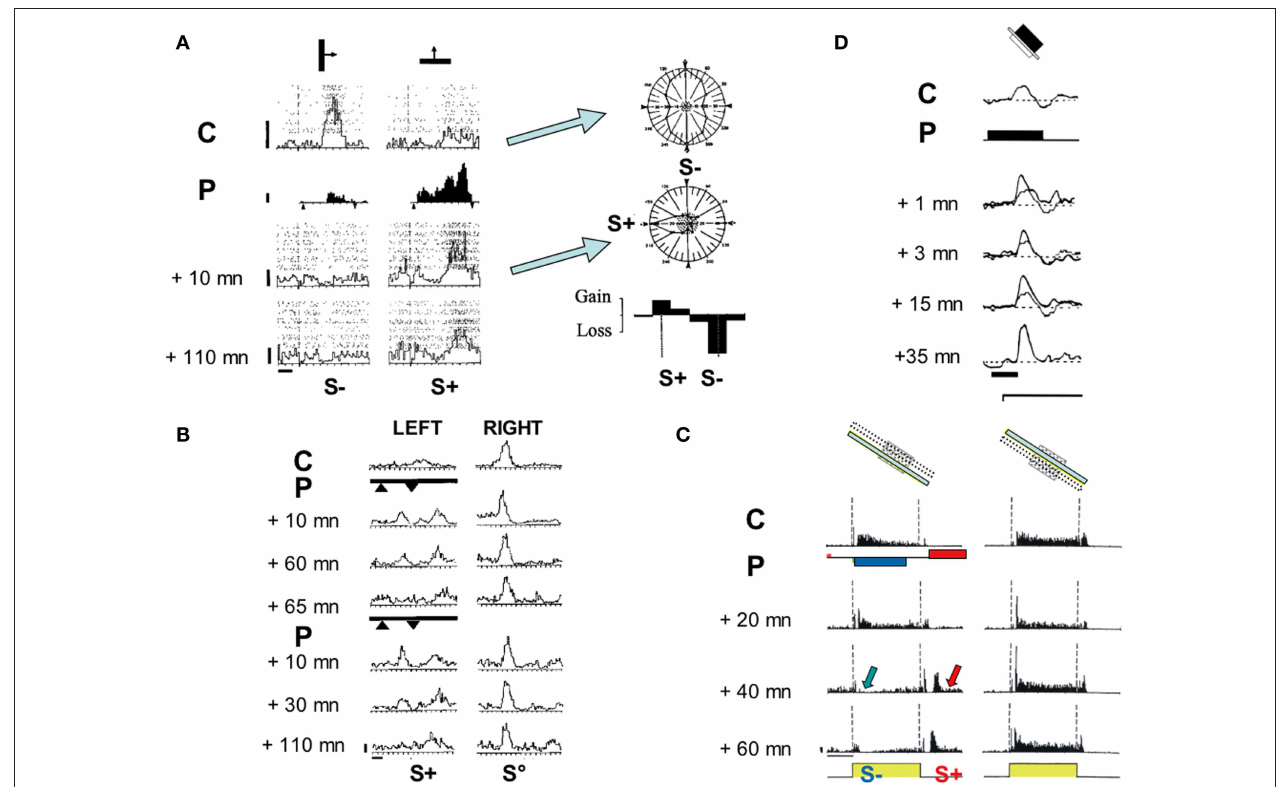
was retained for 60 min. After extinction ( + 65 min), this effect was reinstated by a second pairing (imposing a 90% increase in firing during 24 S + trials), which was retained for 110 min. The response to stimulation through the unpaired (S ° ) right eye was unchanged. Calibration: vertical 10 ap s − 1 , horizontal 1 s and 1.5 ° . (C) Change of the ON/OFF balance (adapted from Debanne et al., 1998). Cell recorded in a 6-week-old kitten. PSTHs represent the cell’s response to the presentation (ON) and extinction (OFF) of an optimally oriented bar in a fixed position of the RF (cartoon). Before pairing (C, control), a tonic “ON” response and a more transient “OFF” response were observed uniformly across the RF. The pairing procedure (P, data not shown) consisted of 50 associations of a negative current pulse ( − 3 nA, 2120 ms duration) with the onset of the light bar and a positive current pulse of similar duration ( + 3.2 nA) following the offset of the same stimulus with a constant delay of 500 ms. A progressive change developed over 40 min after pairing, resulting in a significant depression of the “ON” response ( p < 0.0005), whereas a late “OFF” response appeared de novo in the paired position. The latency of the new response precisely matched the onset delay of the iontophoretic pulse used during pairing. The “ON—OFF” ratio was unchanged in the unpaired position. The modification in the paired position was still present 1 h after the end of the pairing procedure, at which time the neuron was lost. Calibration bars: 1 s; 20 ap s − 1 . (D) Intracellular pairing (adapted from Frégnac et al., 1994b). Simple cell recorded intracellularly in vivo in a 10-week-old kitten. Averaged composite potential evoked by the onset of the stimulus in the ON subfield (C: control, 21 trials). During pairing (P, black line) the stimulus onset was paired with a depolarizing pulse (200 ms, 1.2 nA, 30 associations). A significant potentiation of the PSP was induced after pairing (thin line: control PSP, thick lines: after pairing at 1, 3, 15, and 35 min). The unpaired OFF response in the OFF subfield (not shown), the resting membrane potential ( − 67 mV, dotted lines) and the input resistance (30 M Ω ) were unchanged following pairing. Calibration bar: 100